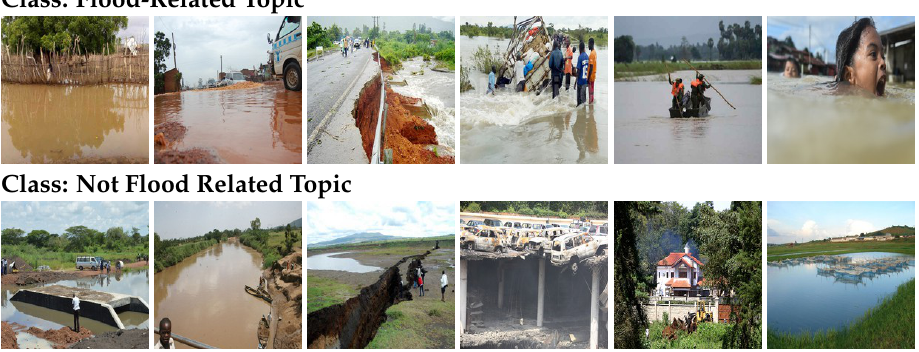
Figure 5. INTD Dataset: Random images of “Flood-Related Topic” and “Not Flood-Related Topic”